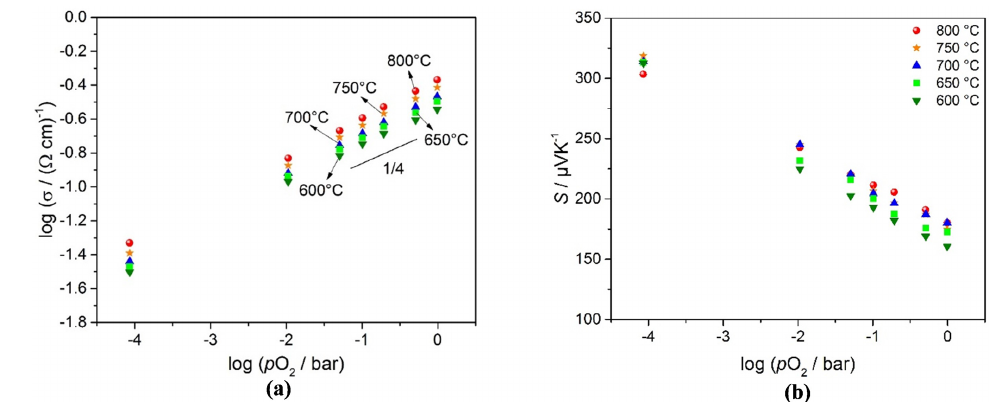
Figure 4. (a) Double logarithmic representation of electrical conductivity vs. p O 2 and (b) a semilogarithmic representation of the Seebeck coefficient vs. p O 2 of BFAT30 AD thick film between 600 and 800 ◦